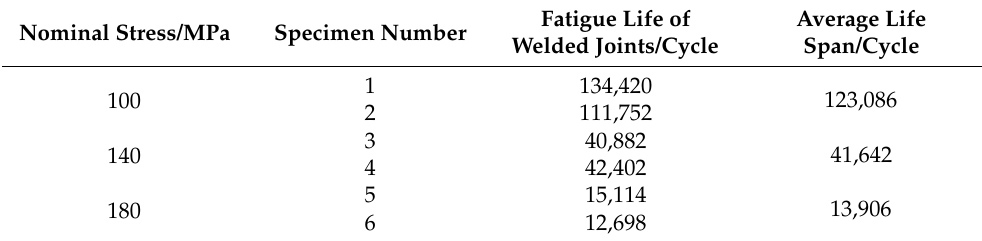
Table 4. Number of fatigue life cycle for the welded joints.